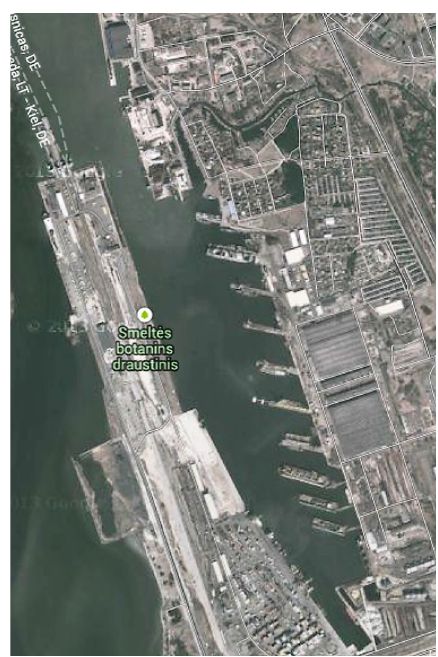
Fig. 3. A part of the Port of Klaipėda in Malkų Bay (width of the entrance channel – about 80 m, ship turning basin – 280 m; improvement should increase the basin up to 320